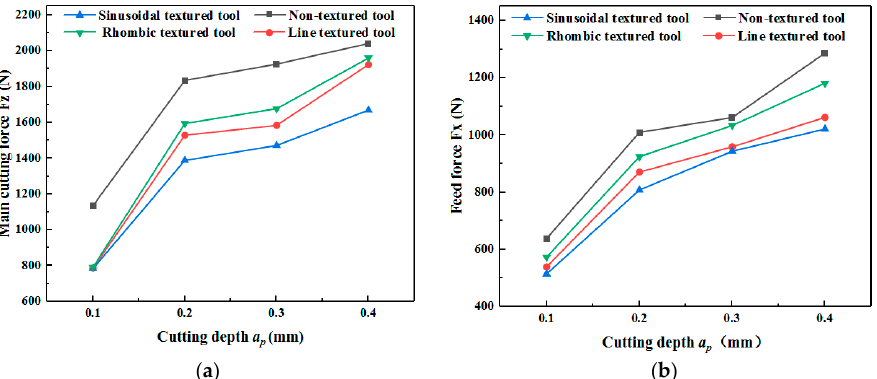
Figure 3. Main cutting force and feed force of tools at different cutting depths (v = 47.7 m/min). ( a ) Main cutting force; ( b ) Feed force.